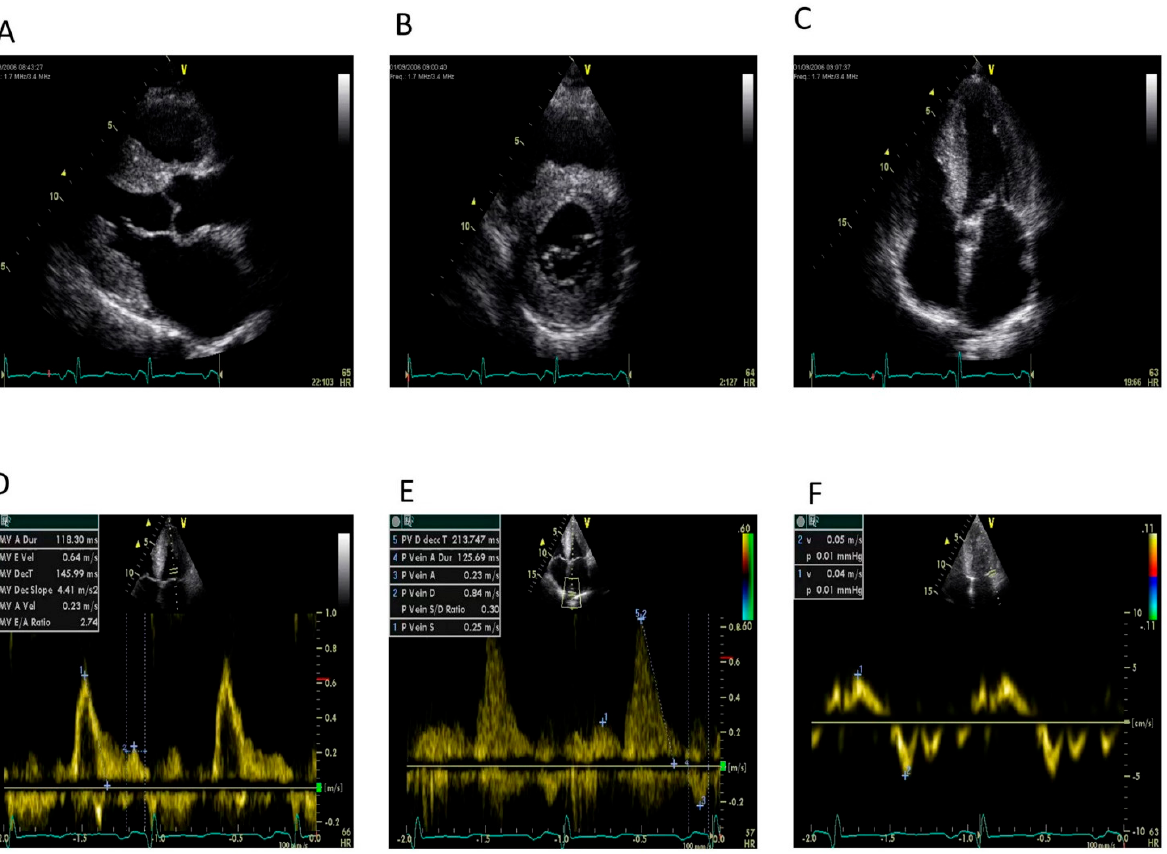
Figure 3. Sequence of still images showing typical echocardiographic features of cardiac amyloidosis. ( A ): Two-dimensional (2-D) parasternal long axis showing an increase of left ventricular wall thickness—in both the interventricular septum and the posterior wall (concentric hypertrophy)—and left atrial dilatation. ( B ): Two-dimensional parasternal short axis. ( C ): Two-dimensional apical four-chamber view. In B and C, it is possible to highlight not only the left ventricular hypertrophy but also the biatrial dilatation. ( D ): Pulsed wave Doppler of mitral inflow showing a restrictive pattern at transmitral flow: increase in E/A ratio and normal E wave deceleration time with a marked reduction in transmitral A wave velocity. ( E ): Pulsed wave Doppler of pulmonary vein inflow showing marked diastolic prominence and increased duration and peak velocity of atrial reversal compared with the transmitral signal. ( F ): Pulsed tissue Doppler of the lateral mitral annulus showing marked reduction in apical systolic and diastolic velocities (normal velocities: >6 cm/s and >8 cm/s, respectively). Images courtesy of Professor Elliott, University College London, UK.